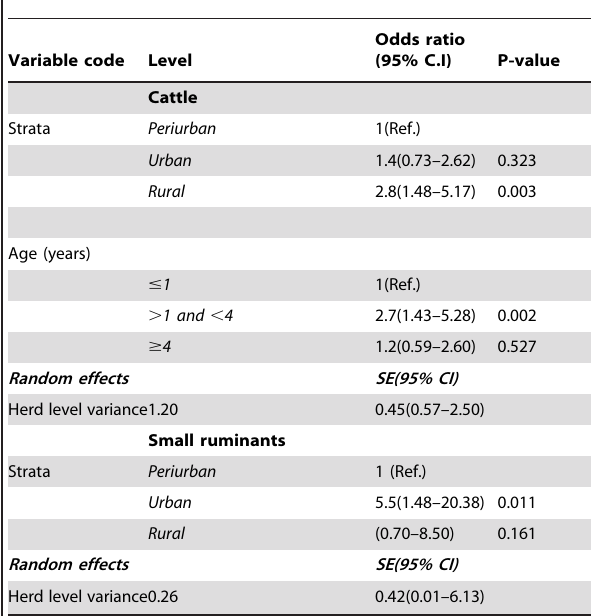
Table 6. Final model of animal population level risk factors associated with brucellosis seropositivity among cattle and small ruminants.